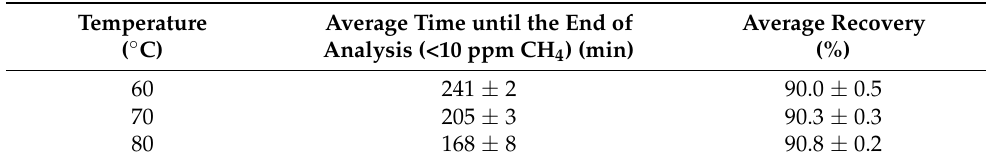
Table 1. Average time until completion (<10 ppm CH 4 measured) and calculated recovery